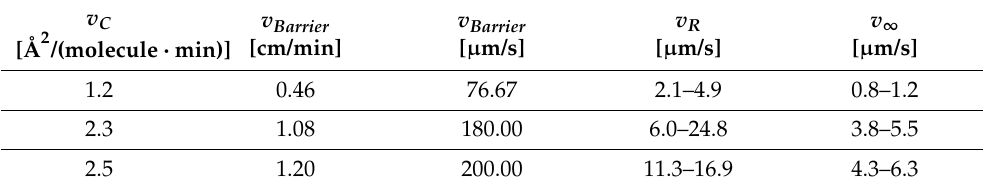
Table 1. Comparison of velocities influencing domain growth. v C is the compression velocity calculated from the dimensions of the Langmuir trough and the barrier velocity v Barrier . v R is the growth velocity of the main branch and v ∞ the flow velocity in the LE phase of molecules far away from the domain, yet flowing already toward the